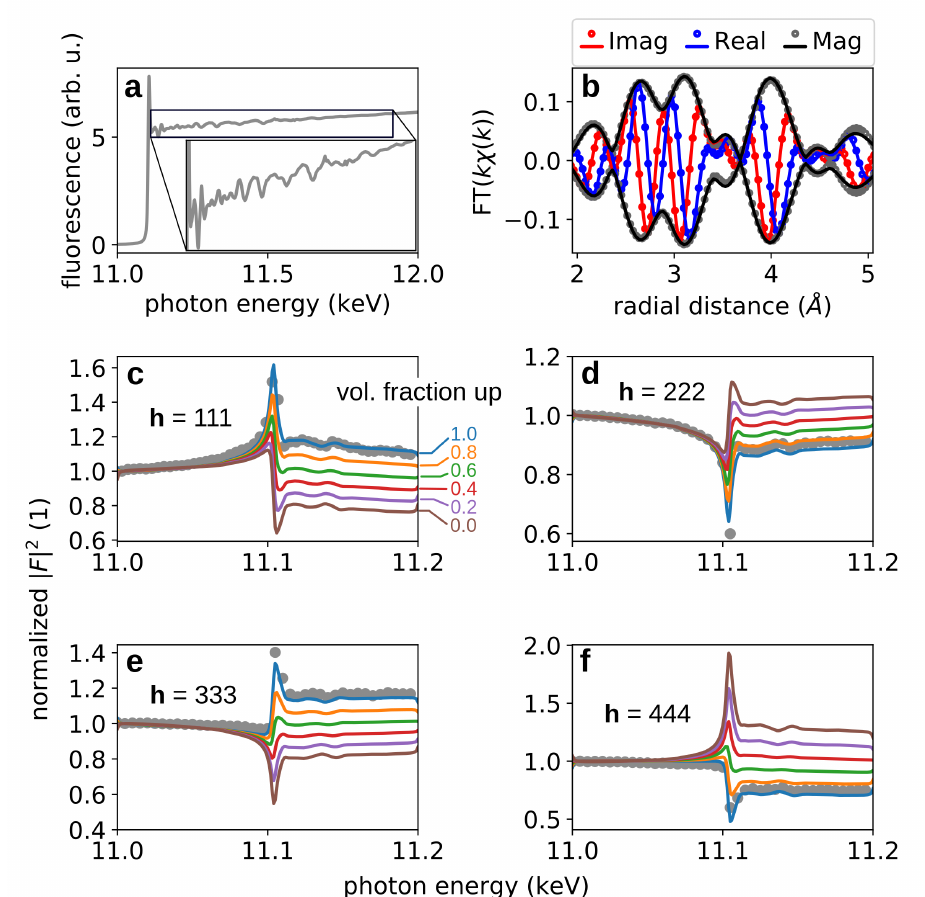
Figure 3. X-ray absorption and diffraction intensity spectra of a GeTe film near the Ge-K edge. ( a ) X-ray fluorescence intensity of the Ge-K line across the absorption edge. An inset shows magnified the oscillatory part above the absorption edge; ( b ) shows the Fourier transform (FT) of this oscillatory part (data points) in comparison with a model (solid lines). Red, blue and black curves and data points correspond to the real, and imaginary part, as well as the magnitude of the Fourier transform. ( c – f ) show the normalized anomalous diffraction intensities around the Ge-K edge for several hhh Bragg reflections (gray data points). The data are overlaid with model curves obtained by assuming various volume fractions for the polarization direction up (+) within the illuminated